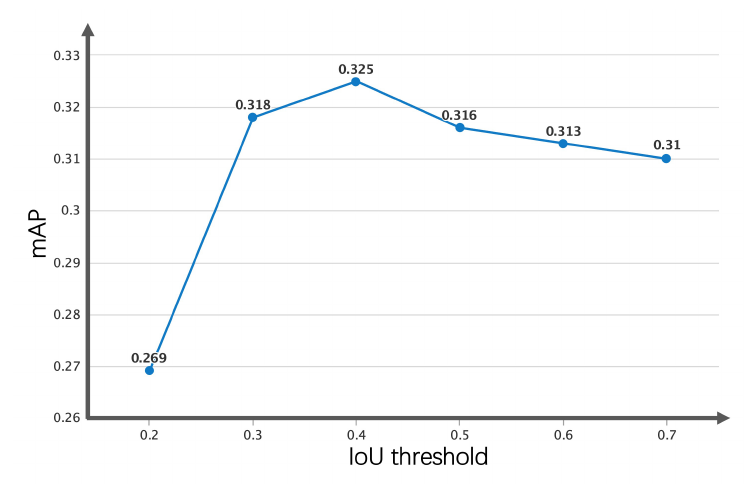
Figure 6. Equilibrium parameter IoU